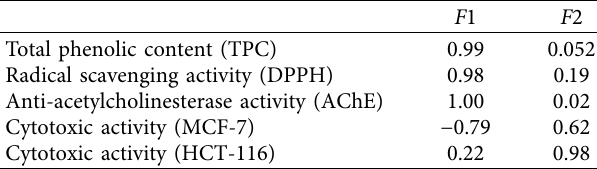
Table 7: Correlations between variables and factors.